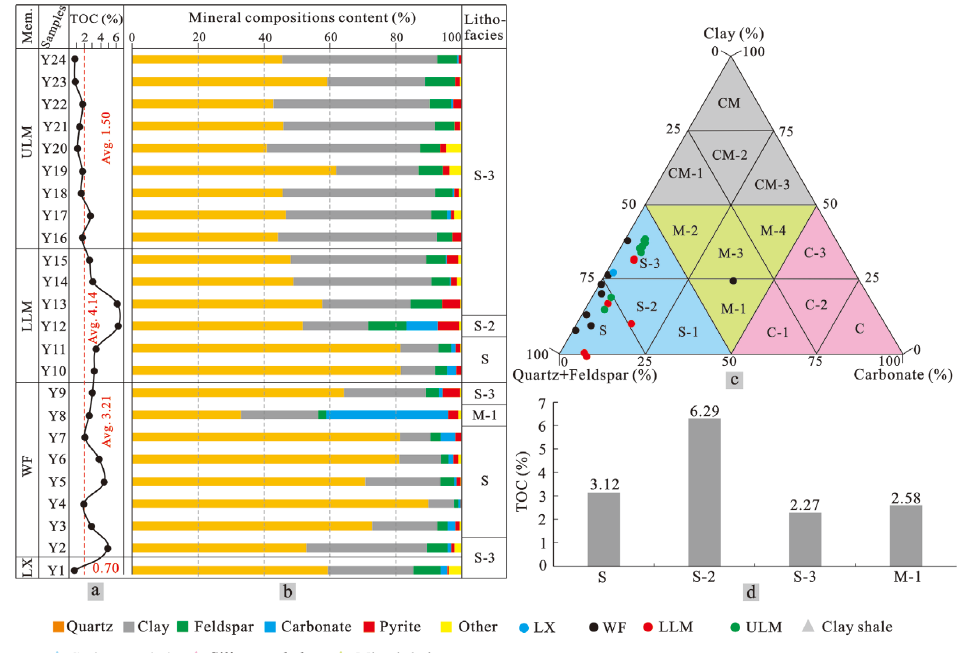
Figure 3. ( a ) Vertical variation in TOC content shows that the WF and LLM include organic-rich shales. ( b ) The percentage of bulk mineral compositions shows that quartz contents decrease and clay contents increase from the bottom to the top. ( c ) The lithofacies classification shows that most samples are potted in the field of siliceous shales. ( d ) TOC contents in different subclass lithofacies show that S-2 and S have higher TOC values. Note: CM, CM-1, CM-2, and CM-3 represent mudstone, siliceous argillaceous shale, argillaceous shale, and calcareous argillaceous shale, respec- tively. C, C - 1, C - 2, and C - 3 represent limestone, siliceous calcareous shale, calcareous shale, and shale, respectively. S, S-1, S-2, and S-3 represent siliceous rock, calcareous siliceous shale, 4 represent calcareous siliceous mixed shale, argillaceous siliceous mixed shale, mixed shale, and